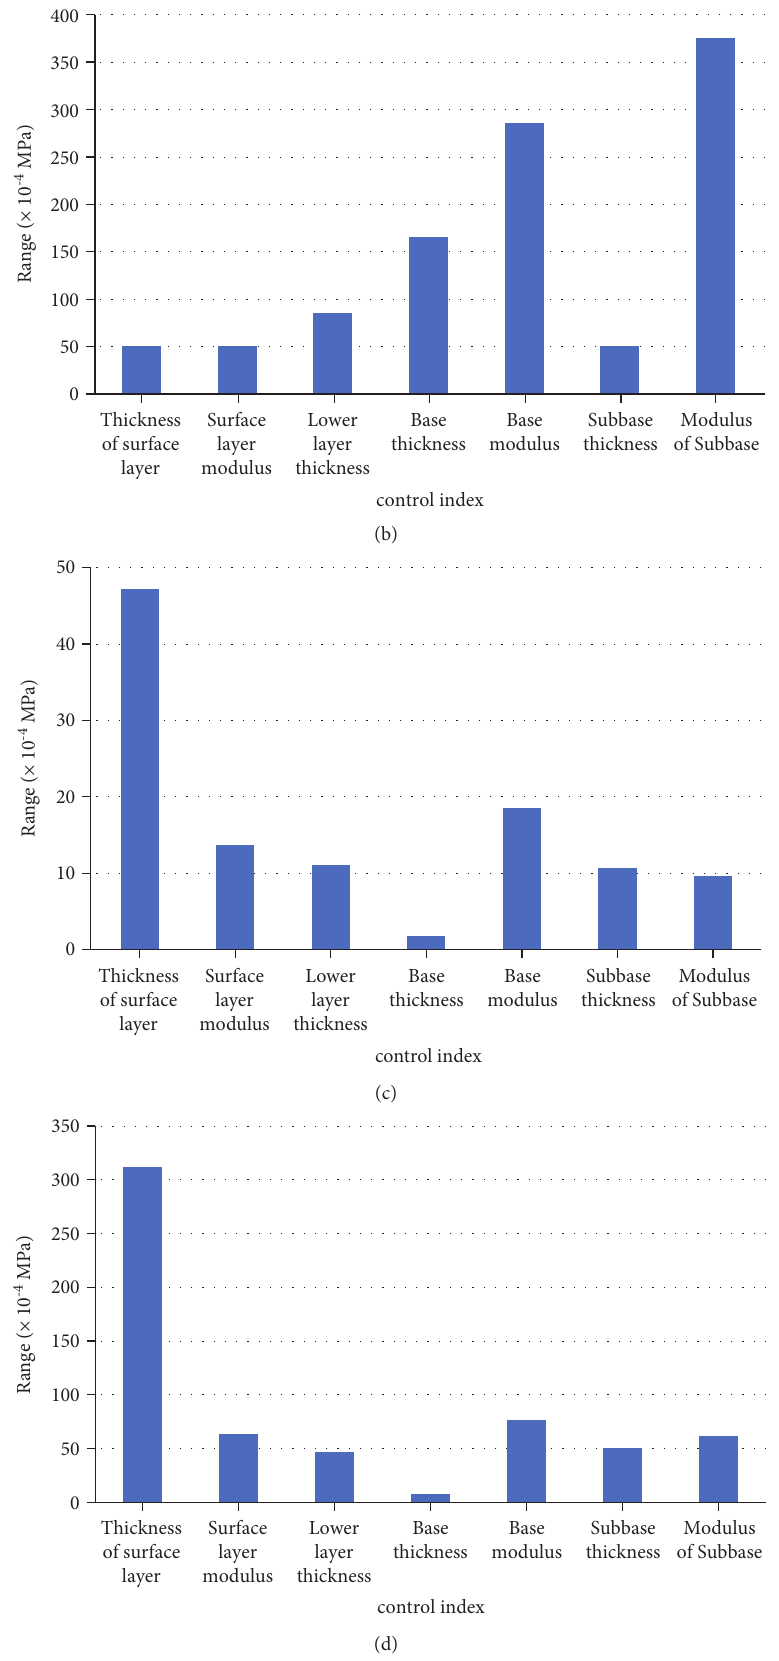
Figure 2: Range diagram of working condition I. (a) Tensile stress at the bottom of inorganic binder base course. (b) Tensile stress of inorganic binder subbase. (c) Permanent deformation of asphalt concrete surface layer. (d) Permanent deformation of the lower layer of asphalt concrete